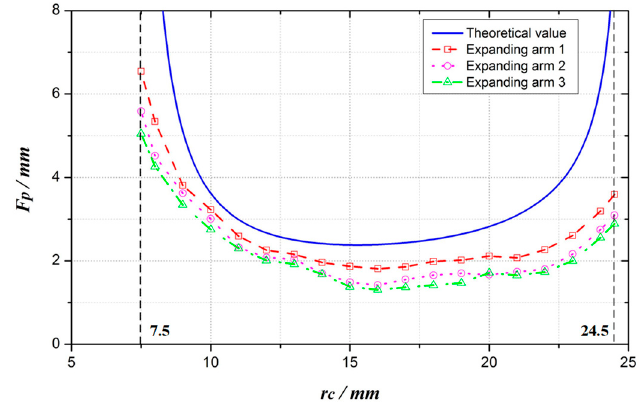
Figure 19. Experimental and theoretical value of expanding force.